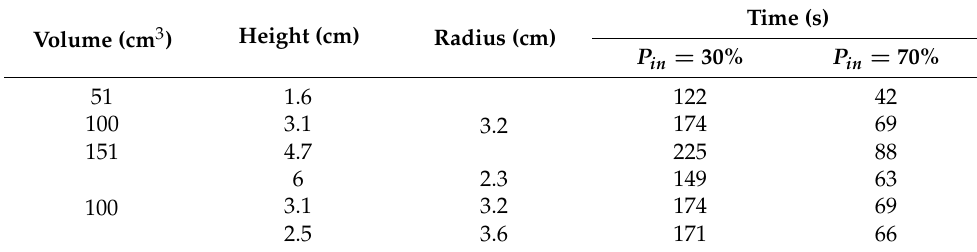
Table 4. Microwave heating on cylindrical water samples of different volumes at two power